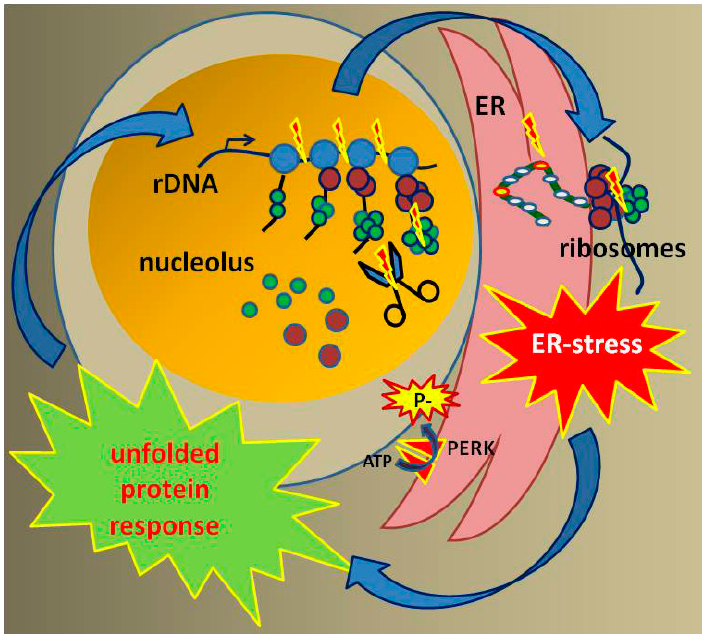
Figure 2. Graphical illustration of the hypothesis: Disturbances in RNA polymerase I transcription result in rRNA processing defects, altered subunit composition, and reduced translational fidelity of